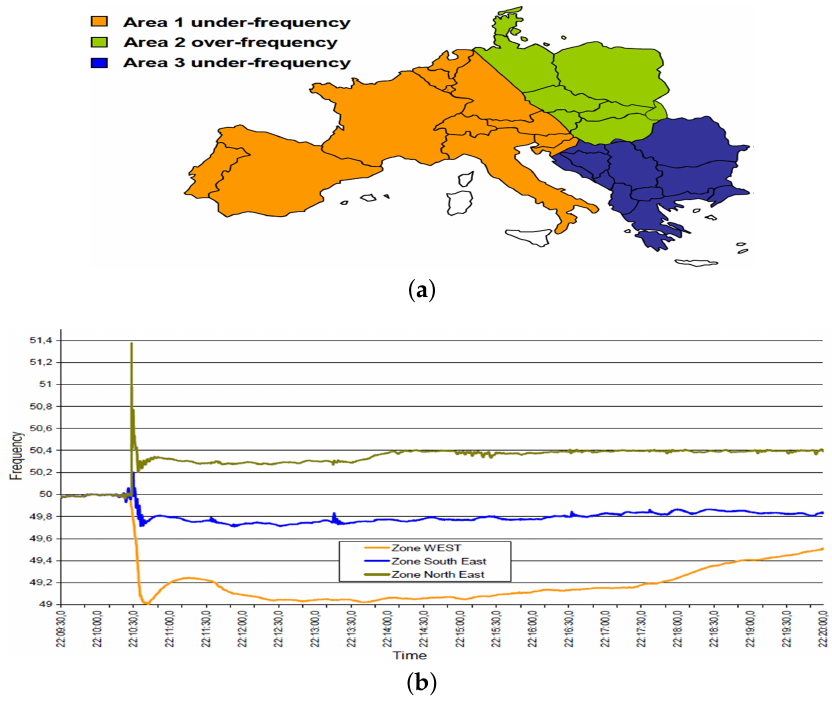
Figure 1. ( a ) Schematic map of UCTE area that split into three areas; and ( b ) frequency recordings after the split in the blackout on 4 November 2006, in the European interconnected electric grid